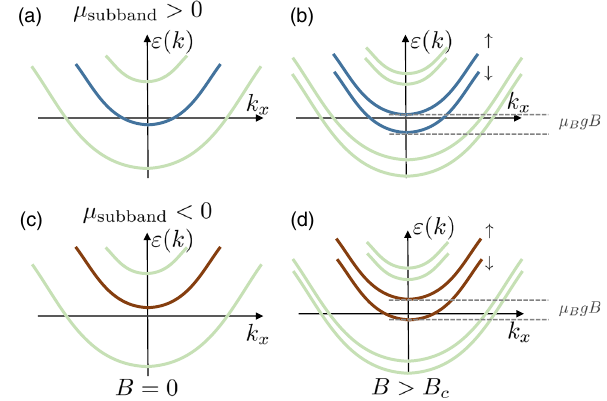
FIG. 8. Illustration of typical band structures, and the two different scenarios for the topological phase transition from an even to an odd number of occupied spin subbands. Panels (a) and (c) show the situation without magnetic field, B ¼ 0 , where a subband is slightly below [(a), one spin-degenerate Fermi point] or above the chemical potential [(c), no Fermi points]. Upon turning on a finite field that exceeds the distance from the bottom of these subbands to the chemical potential, the corresponding panel on the right [(b) and (d)] is obtained, where an odd number of spin-split subbands is